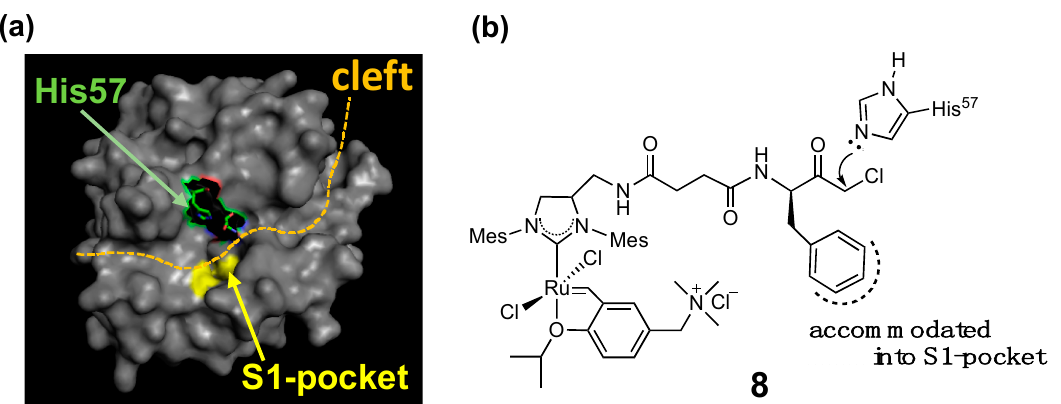
Figure 5. Mechanism explaining the regioselective conjugation of complex 8 onto His57 in α -chymotrypsin [18,25]; ( a ) whole structure of α -chymotrypsin from bovine pancreas (PDB (protein data bank) code: 4CHA); ( b ) structure of complex 8 .